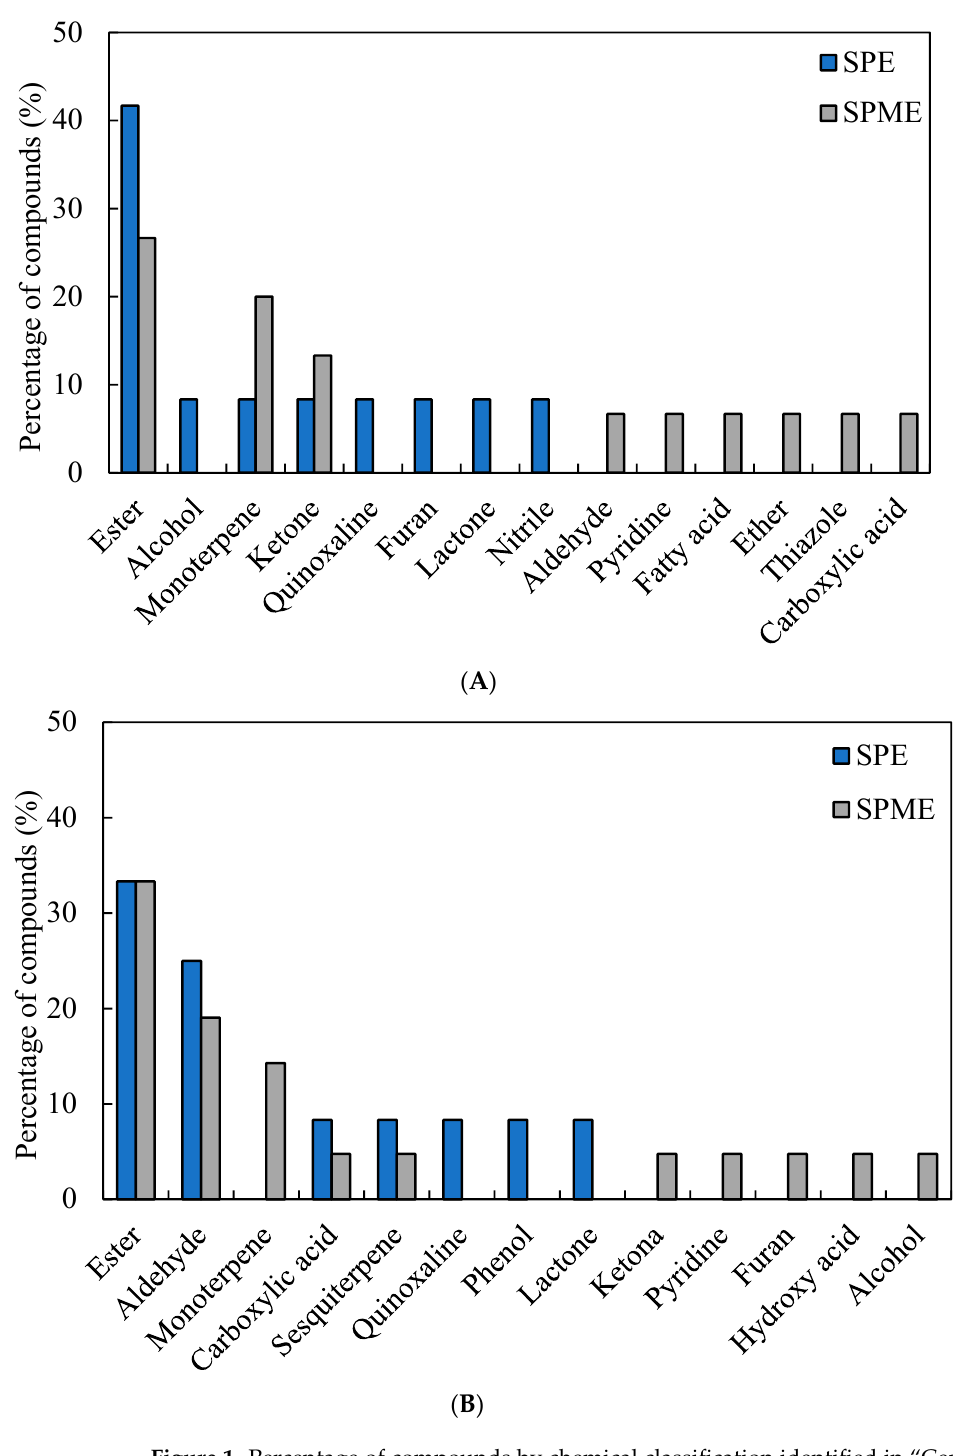
Figure 1. Percentage of compounds by chemical classification identified in “Cerrado” cashew ( A ) and cagaita ( B ) pulps obtained using headspace solid-phase extraction (HS-SPE) and headspace solid-phase microextraction (HS-SPME) with gas chromatography-olfactometry (GC-O).